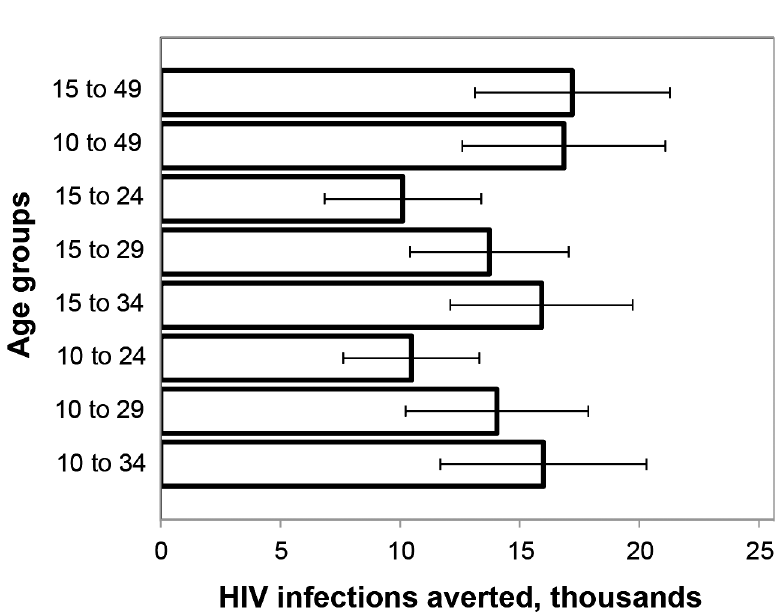
Fig 2. HIV infections averted in scenarios scaling up VMMC among different client age groups. The period for measuring HIV infections averted was 15 years, 2014 – 2028, inclusive. Error bars represent uncertainty